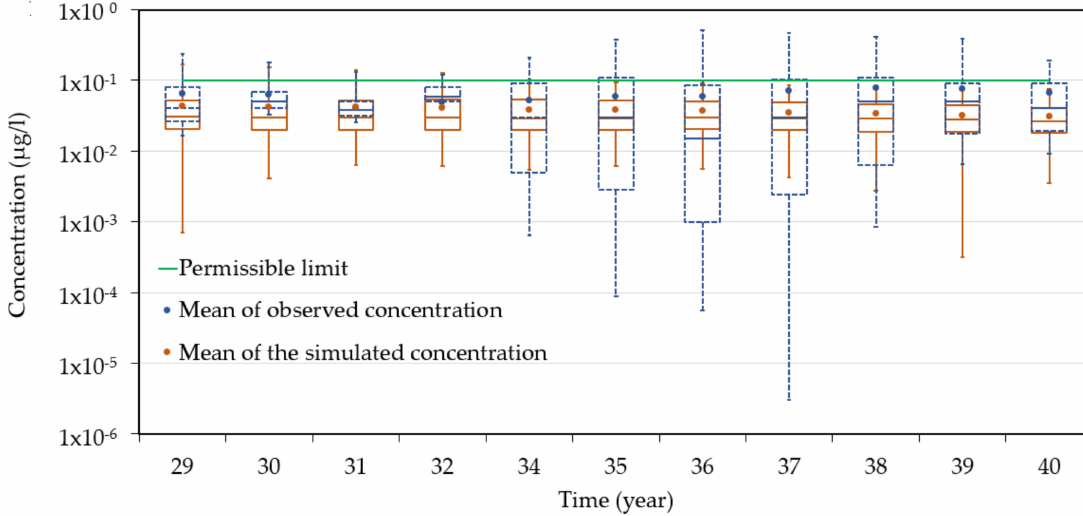
Figure 16. Boxplots of the annual atrazine concentrations observed in monitoring wells (represented in blue color) and simulated (represented in brown color), along with the arithmetic mean of observed and simulated atrazine concentrations (a logarithmic